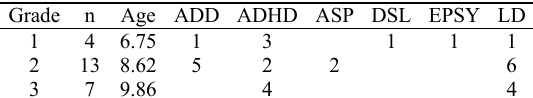
(ADD: Attention deficit disorder; ADHD: Attention deficit hyperactivity disorder; ASP: Asperger syndrome; DSL: Dys- lexia; EPSY: Epilepsy; LD: Learning